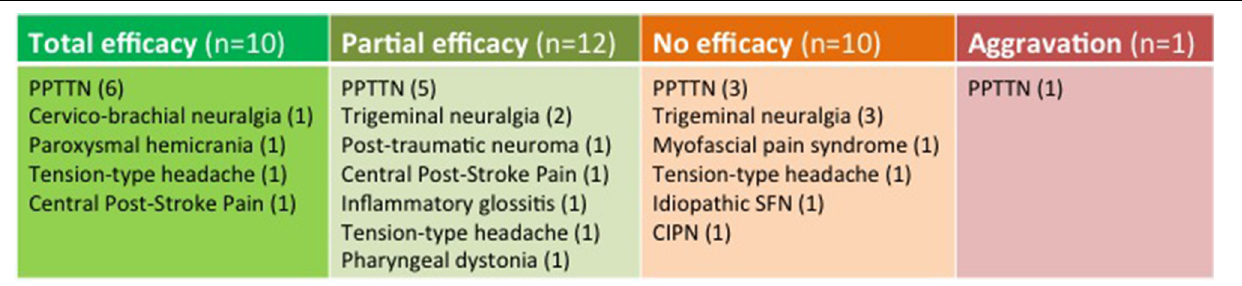
Table II. Ef fi cacy of gabapentinoid prescriptions in the patient cohort (n = 33 patients, after 13 patients were lost to follow-up and 3 were excluded from the analysis: 1 patient had a co-treatment with amitriptyline and 2 ceased treatment early because of severe untoward effects). PPTTN = Painful Post-Traumatic Trigeminal Neuropathy; SFN = Small Fiber Neuropathy; CIPN = Chemotherapy-Induced Peripheral